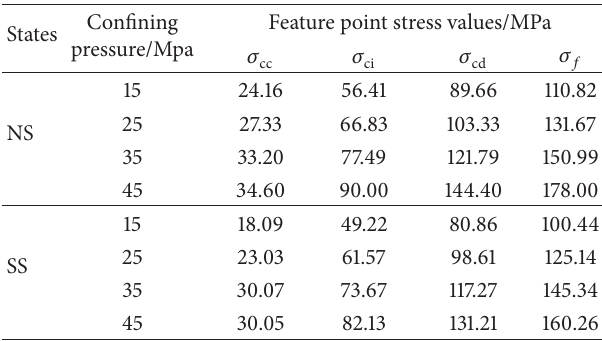
Table 2: Feature point stress for triaxial tests under natural and saturated